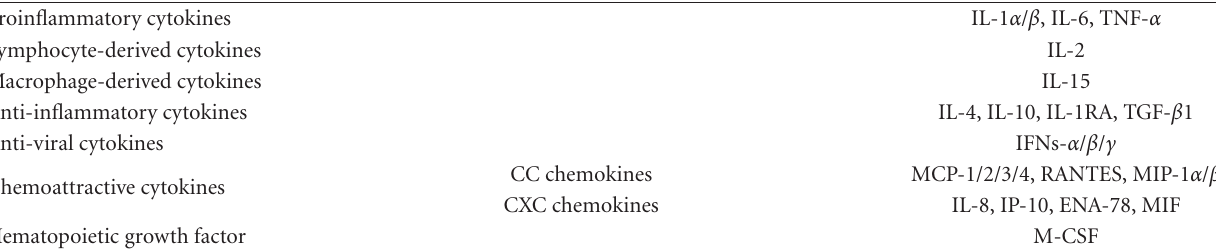
Table 4: Diverse cytokines produced by human fetal